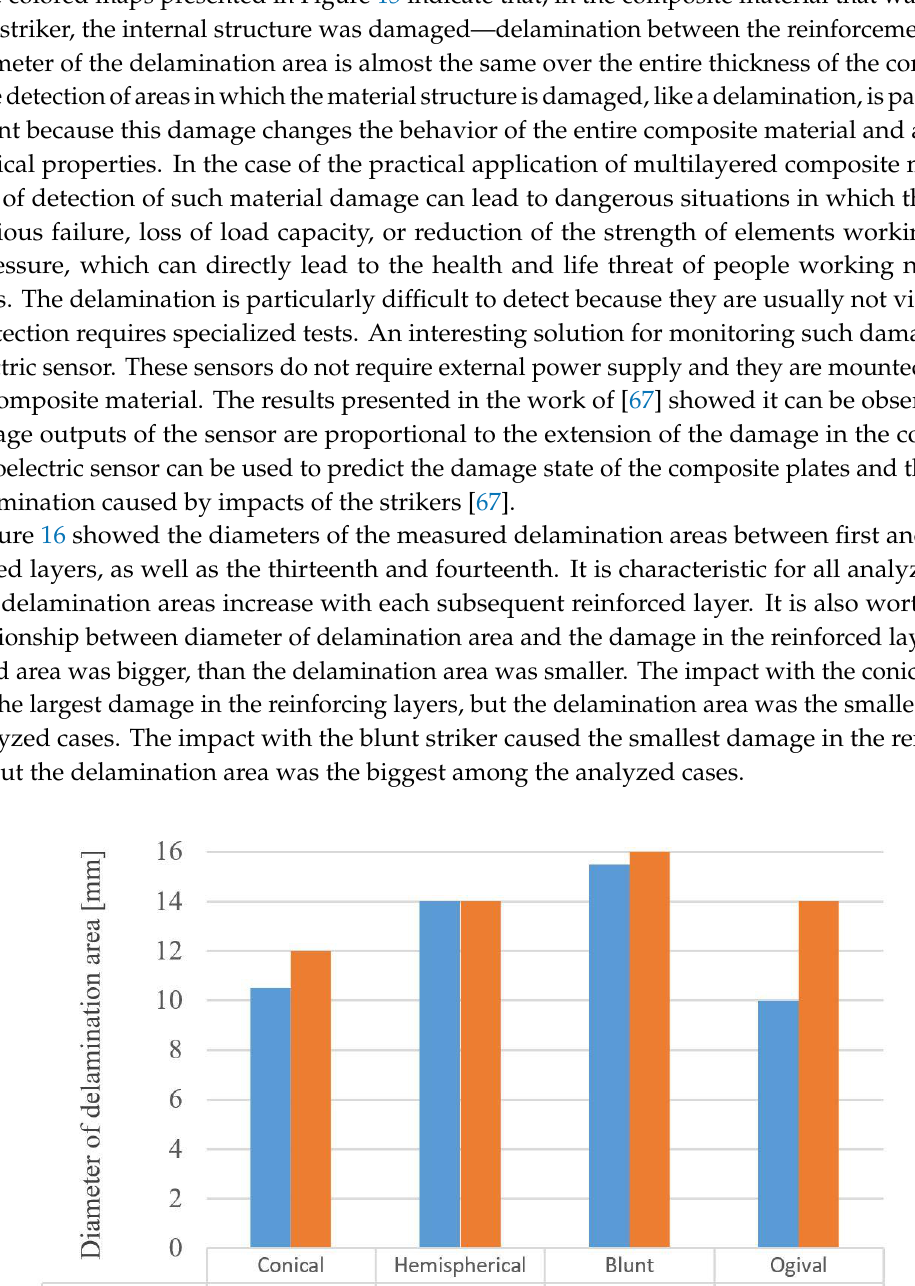
Figure 15. Colored maps of delamination areas after impact of the blunt striker between layers: ( a ) 1 and 2, ( b ) 2 and 3, ( c ) 9 and 10, ( d ) 13 and 14.